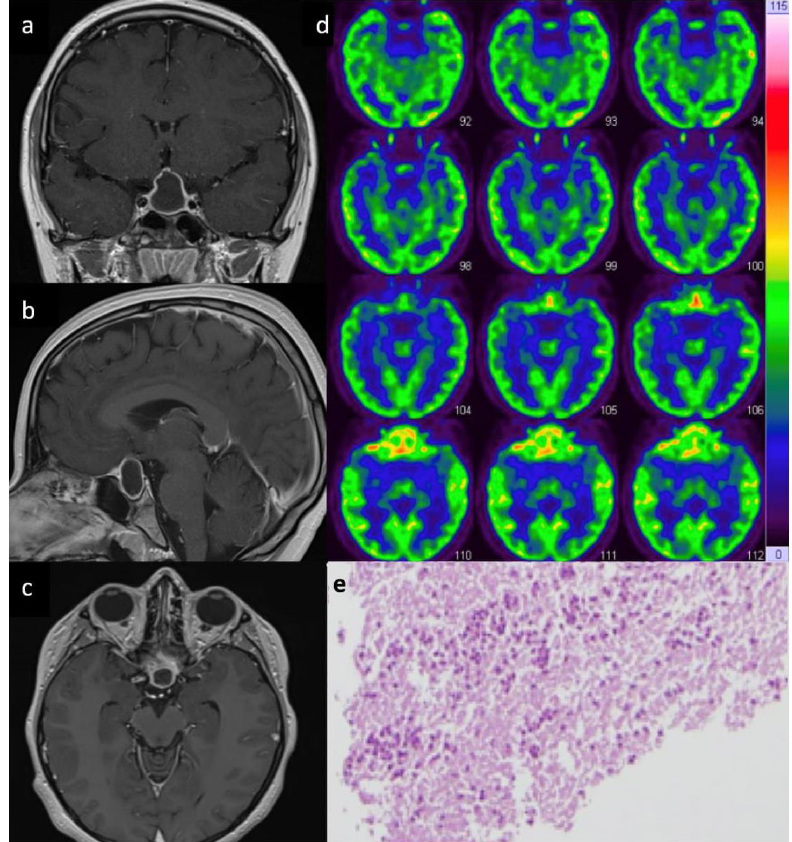
Figure 1. Preoperative T1 weighted enhanced MRI coronal ( a ), sagittal ( b ), and axial ( c ), demon- strating a ring enhancing intra-sellar mass with supra-sellar extension in a 14-year-old boy with a 4 day history of sudden headache, nausea and vomiting associated with thyroid insufficiency. The patient underwent an endoscopic endonasal surgery and the perioperative findings consisted of a primary PA. Bacteriologic investigation revealed a Staphylococcus Aureus infection that was treated by targeted therapy with a favorable outcome. The patient came back 4 months later complaining of progressive headache; an enhanced MRI showed the recurrence of the ring-like intra-suprasellar SOL; on this occasion an 18-FDG PET scan ( d ) showed a hyper-metabolism in the right anterior part of sella, favoring a diagnosis of recurrent PA. Re-do surgery and antibiotic therapy allowed a good outcome without further recurrence at 2-year FU; ( e ) histopathological analysis: the pituitary parenchyma appears fully necrotic and contains an intense pyogenic inflammatory infiltration (hematoxylin eosin ×